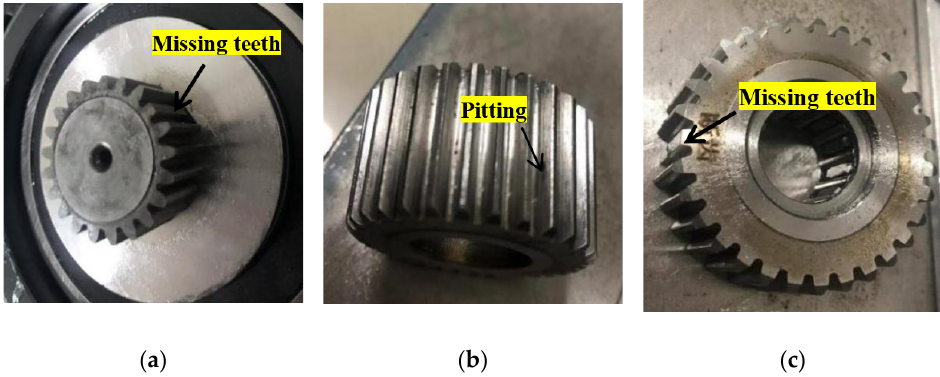
Figure 10. Sun gear and planetary gear missing teeth and planetary gear pitting fault: ( a ) Sun gear missing teeth; ( b ) Planetary gear pitting; ( c ) Planetary gear missing teeth.